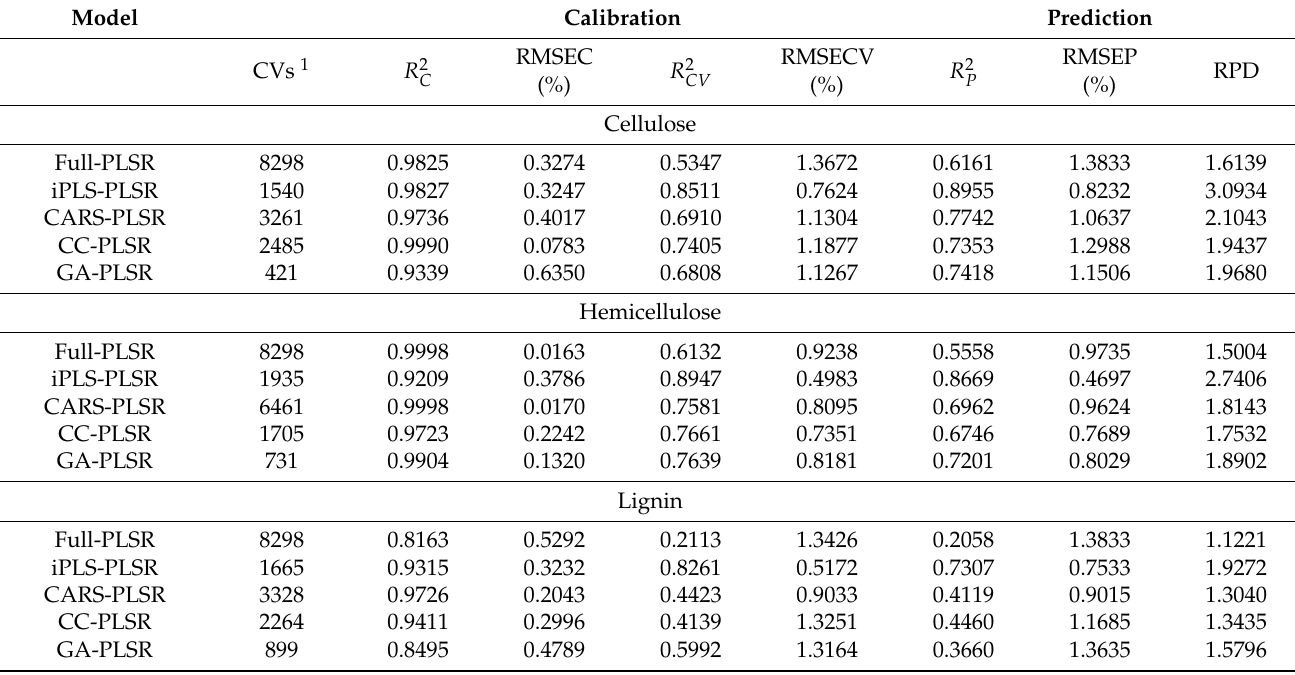
Table 4. Performance of the full-PLSR models with different pretreatment